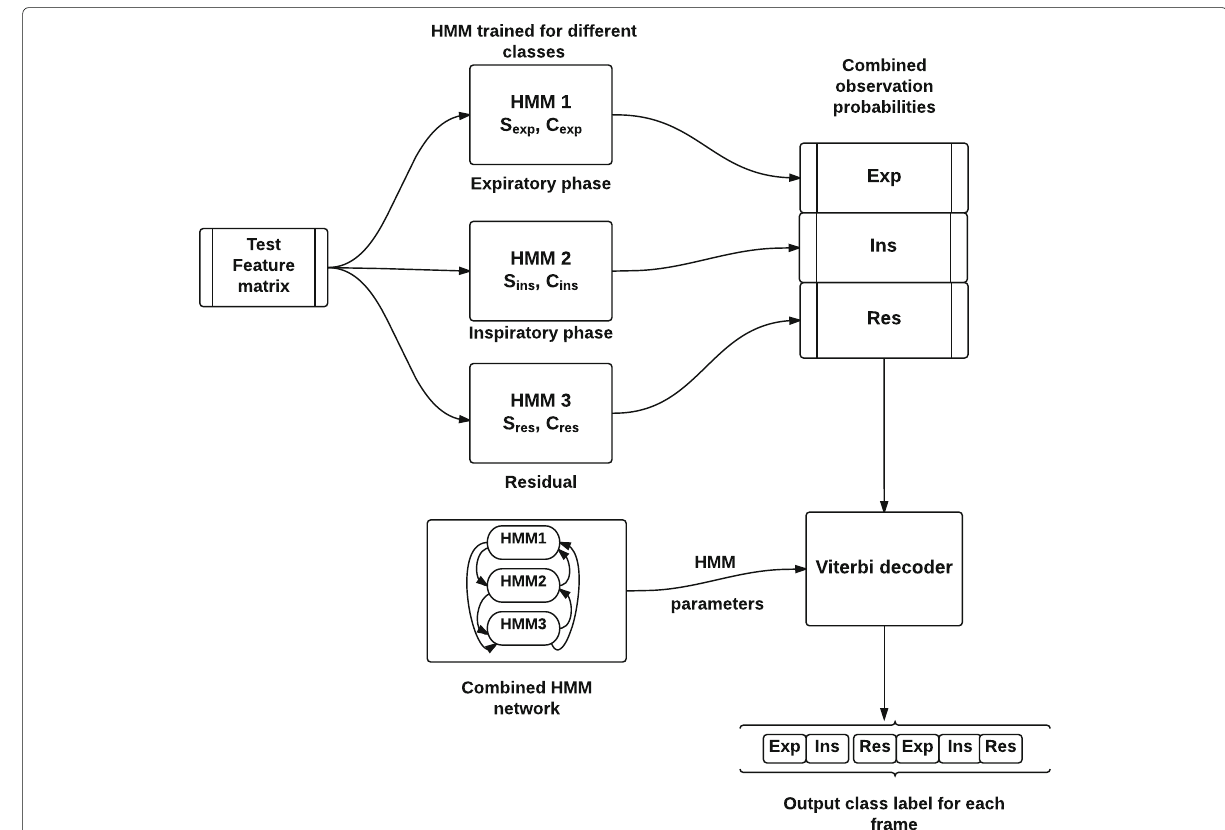
Fig. 4 Implementation of the audio segmentation system. The input to the system is a feature matrix derived from a test audio file. The output is a class label assigned for each frame of the cry signal